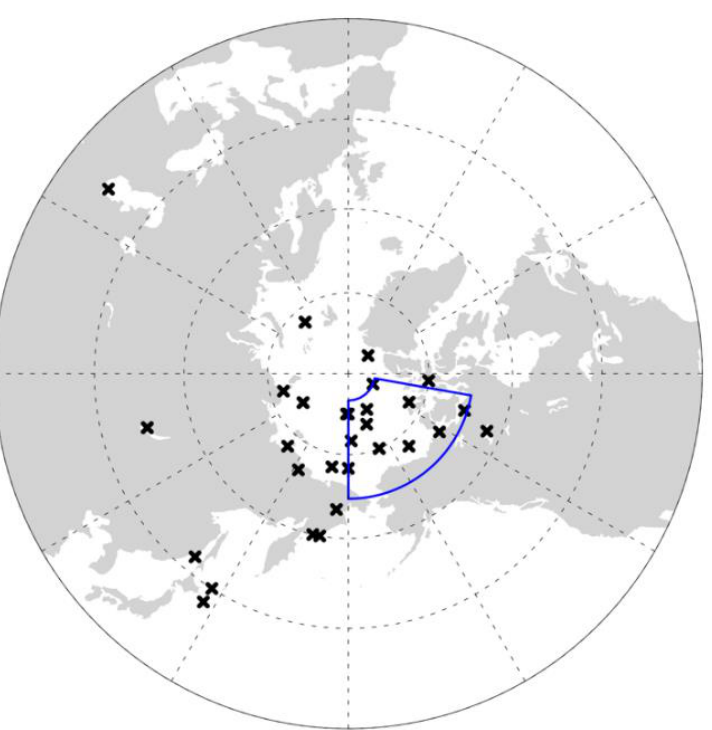
Figure 7. Origin locations of cyclones identified based on the R1 sea level pressure data in the region on days with extreme high levels listed in Table 1. The blue box denotes the region in which storms needed to be located at least once during each day to be included.